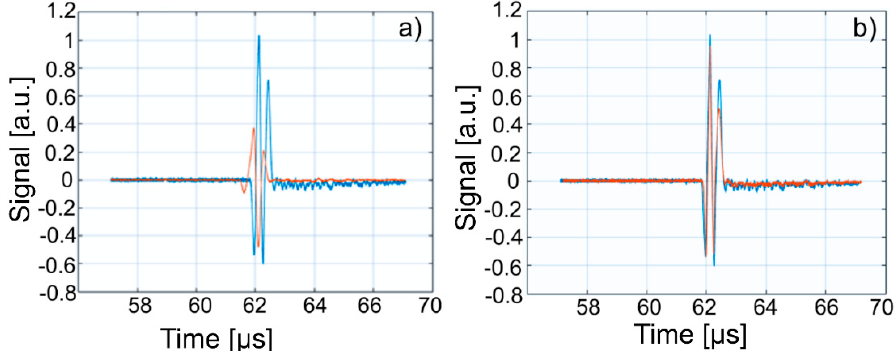
Figure 13. Overlapping of the first echo of Wi (blue) over signals from: WZn ( a ); and Wd ( b ) (orange).